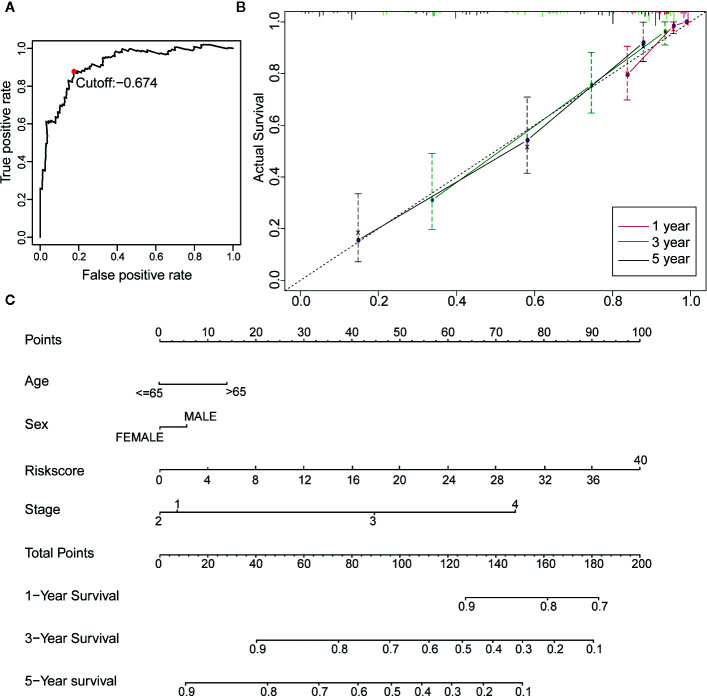
Construction of a Robust nomogram in TCGA training dataset. (A) A time-dependent ROC curve for IRGPs in the training and testing dataset. An IRGP score of −0.674 was used as a cut-off to assign patients to the high- or low-risk group. (B) The 1-, 3-, and 5-year calibration curves of the nomogram. (C) A nomogram of OS was established by 23-IRGP risk score and other clinicopathological parameters.